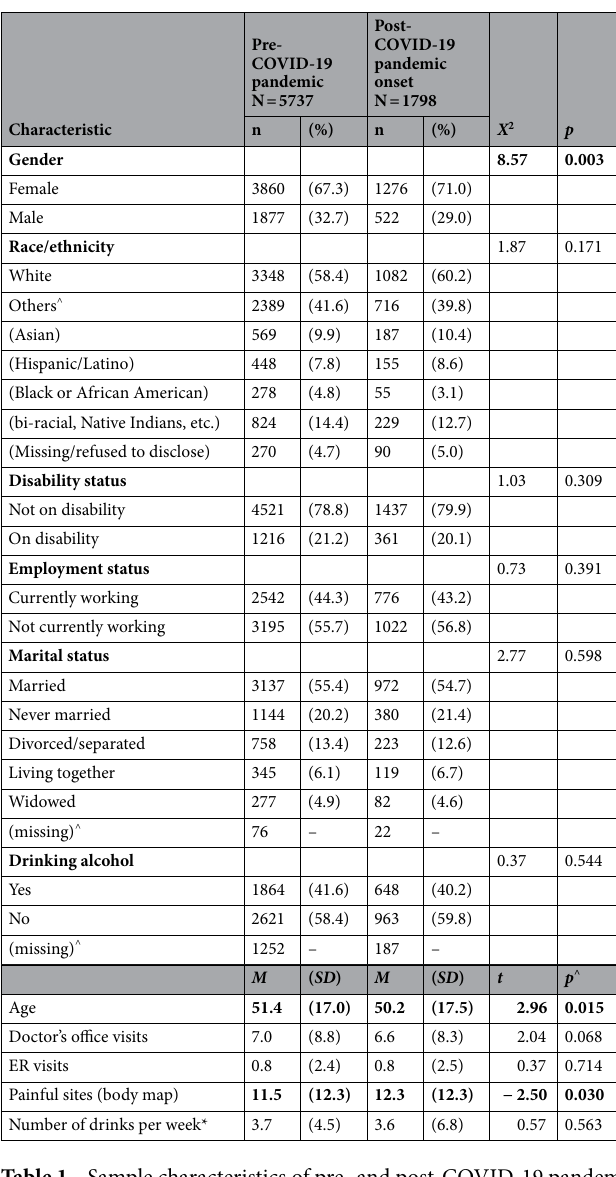
measures ( p s > 0.084). PROMIS-emotional support T-scores were significantly higher in the post-COVID-19 cohort ( M = 52.2, SD = 9.5) than the pre-COVID-19 cohort ( M = 51.2, SD = 9.5, Fig. 4).